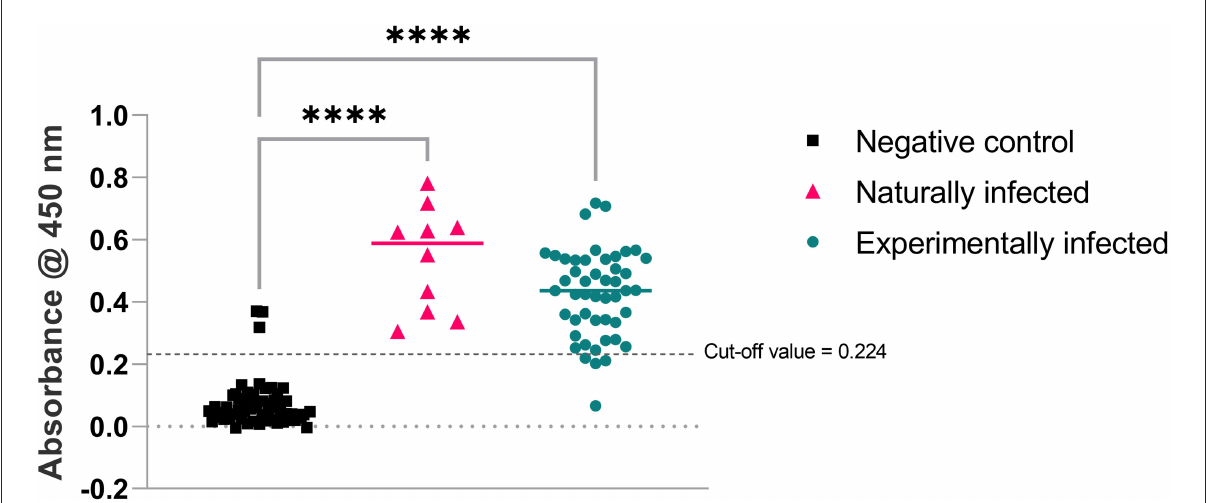
FIGURE6 Absorbance produced by anti-FHA antibodies present in the bird sera used in SLD-ELISA2. Ordinary one-way ANOVA pairwise comparison results were highly significant with **** p < 0.0001 for both naturally and experimentally infected groups compared to the negative control